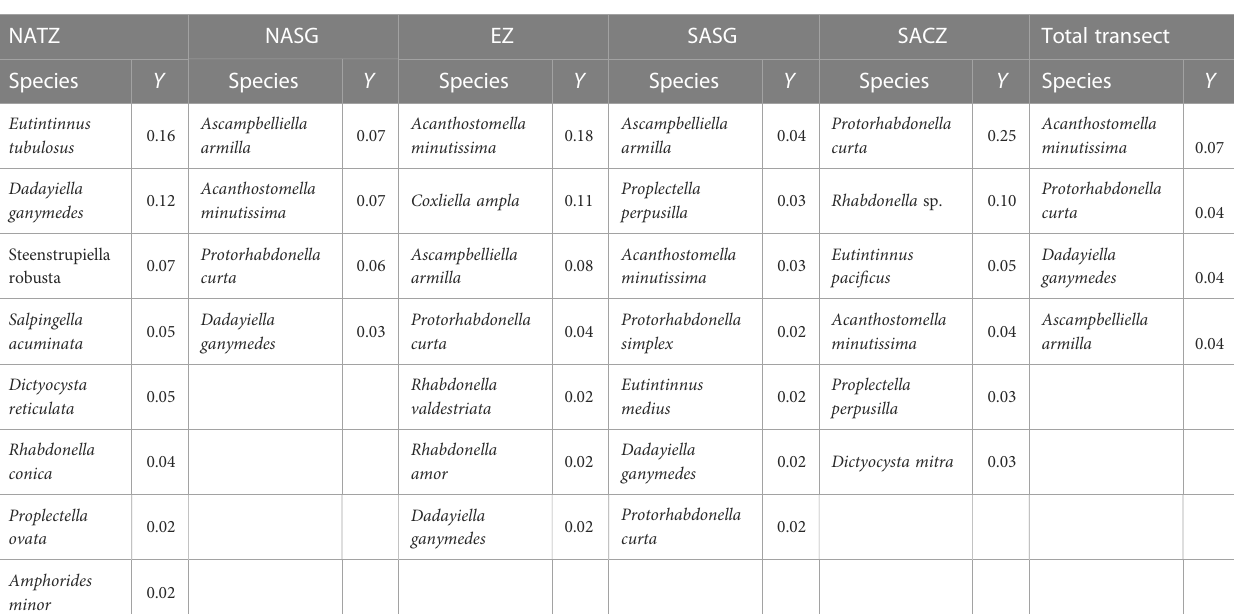
TABLE 3 Dominant species and their dominance index ( Y ) in each biogeographic region and the total